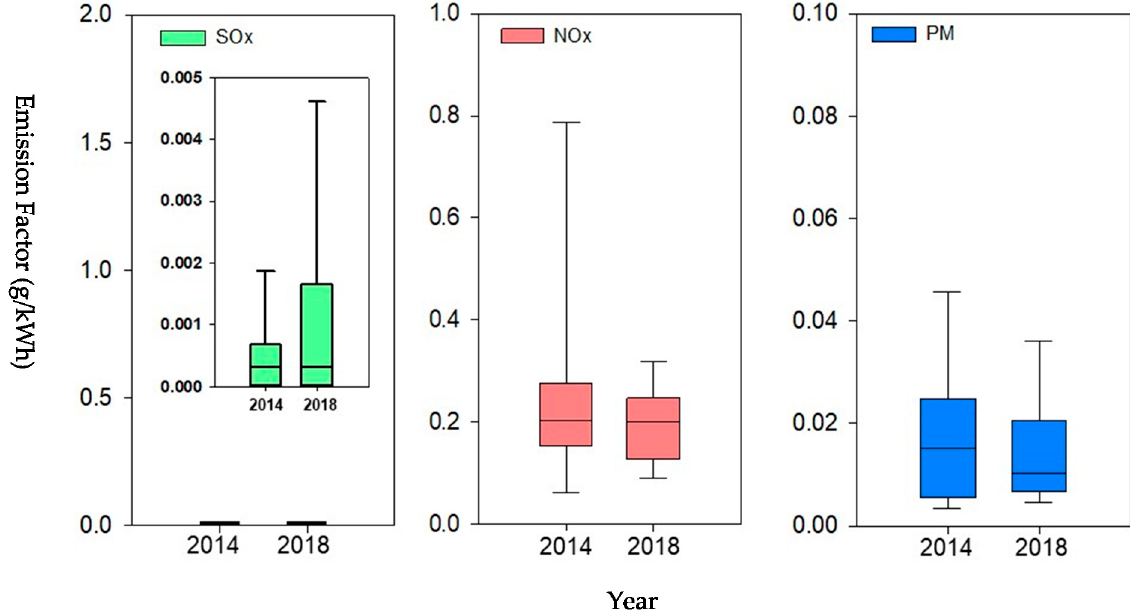
Figure 3. SOx, NOx, and PM emission factors for LNG generation units in Taiwan. N.D. and 0.019 g/kWh, with an average of 0.0016 g/kWh. The NOx emission factor 0.200 g/kWh, reflecting a 5.60-fold difference. The PM emission factor from each generation unit ranged between 0.003–0.038 g/kWh, with an average of 0.014 g/kWh, reflecting a 12.67-fold